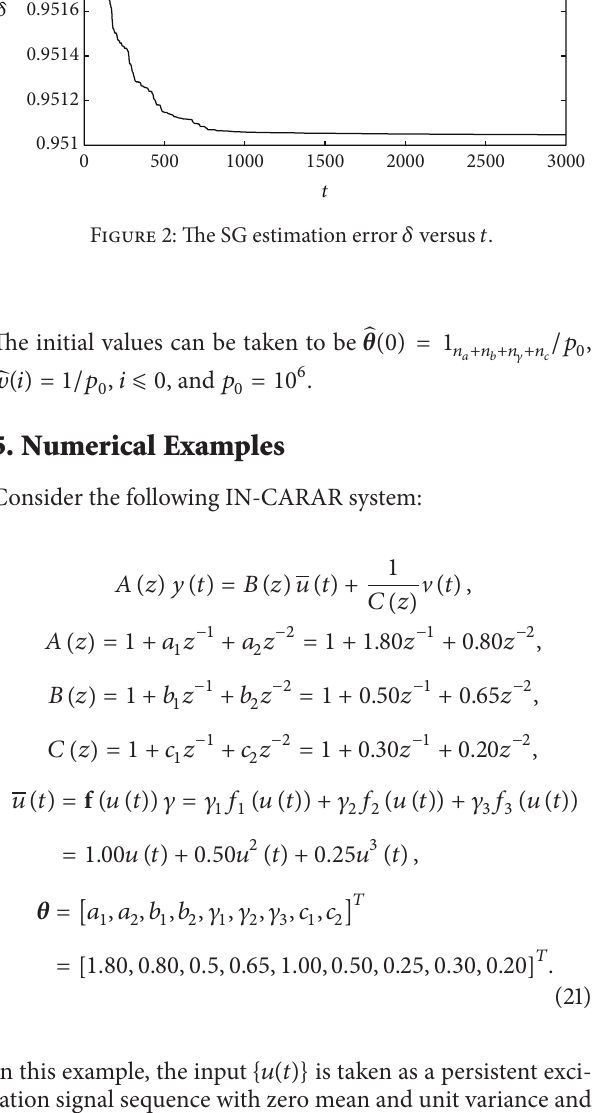
Figure 3: The MISG estimation error 𝛿